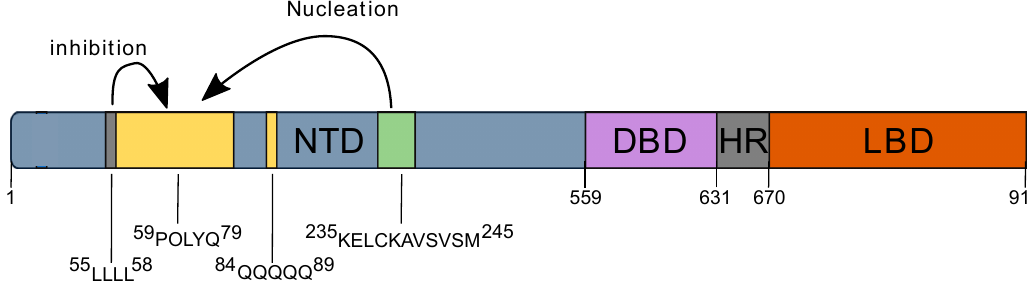
Figure 5. Schematic view of the different possible interactions in androgen receptor (AR) with an impact on AR aggregation. NTD: N-Terminal Domain; DBD: DNA Binding Domain; HR: Hinge Region; LBD: Ligand Binding Domain.